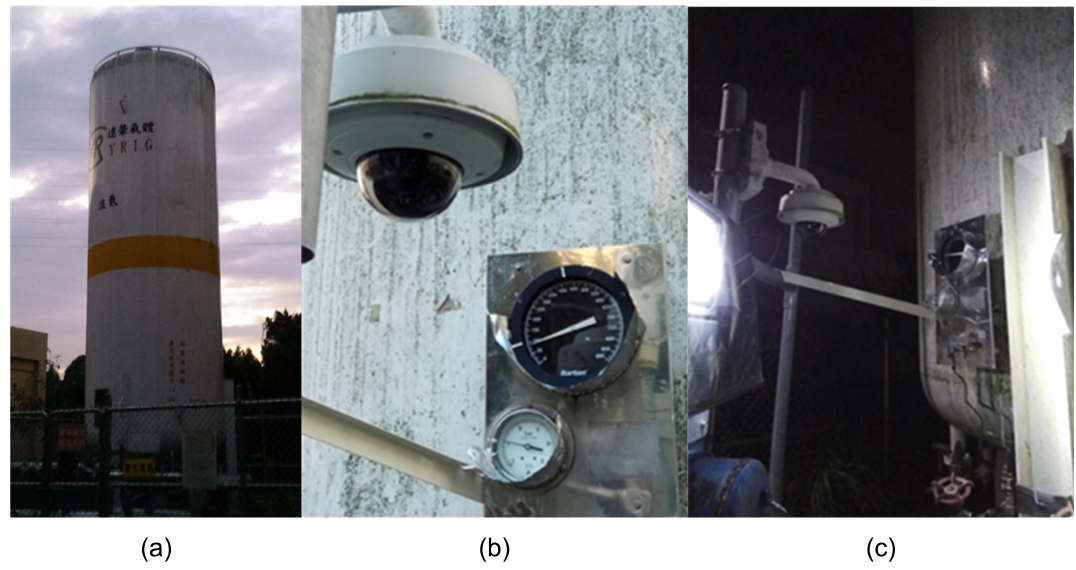
Figure 23. ( a ) A 15 m 3 Liquid nitrogen (LN2) tank setup at outside our laboratory. ( b ) The two significant meters installed on the LN2 tank are the level meter (top) and pressure meter (bottom), and an Internet Protocol (IP) camera is used to monitor these two meters. ( c ) The LN2 tank meters are illuminated by a road lamp and a LED floodlight at night.